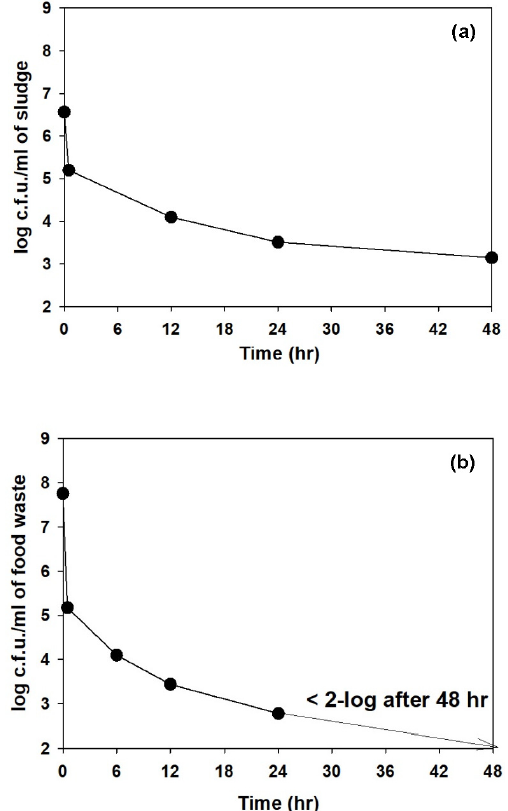
Figure 3. Effect of disinfection at pH 13: ( a ) Sewage sludge, ( b ) food